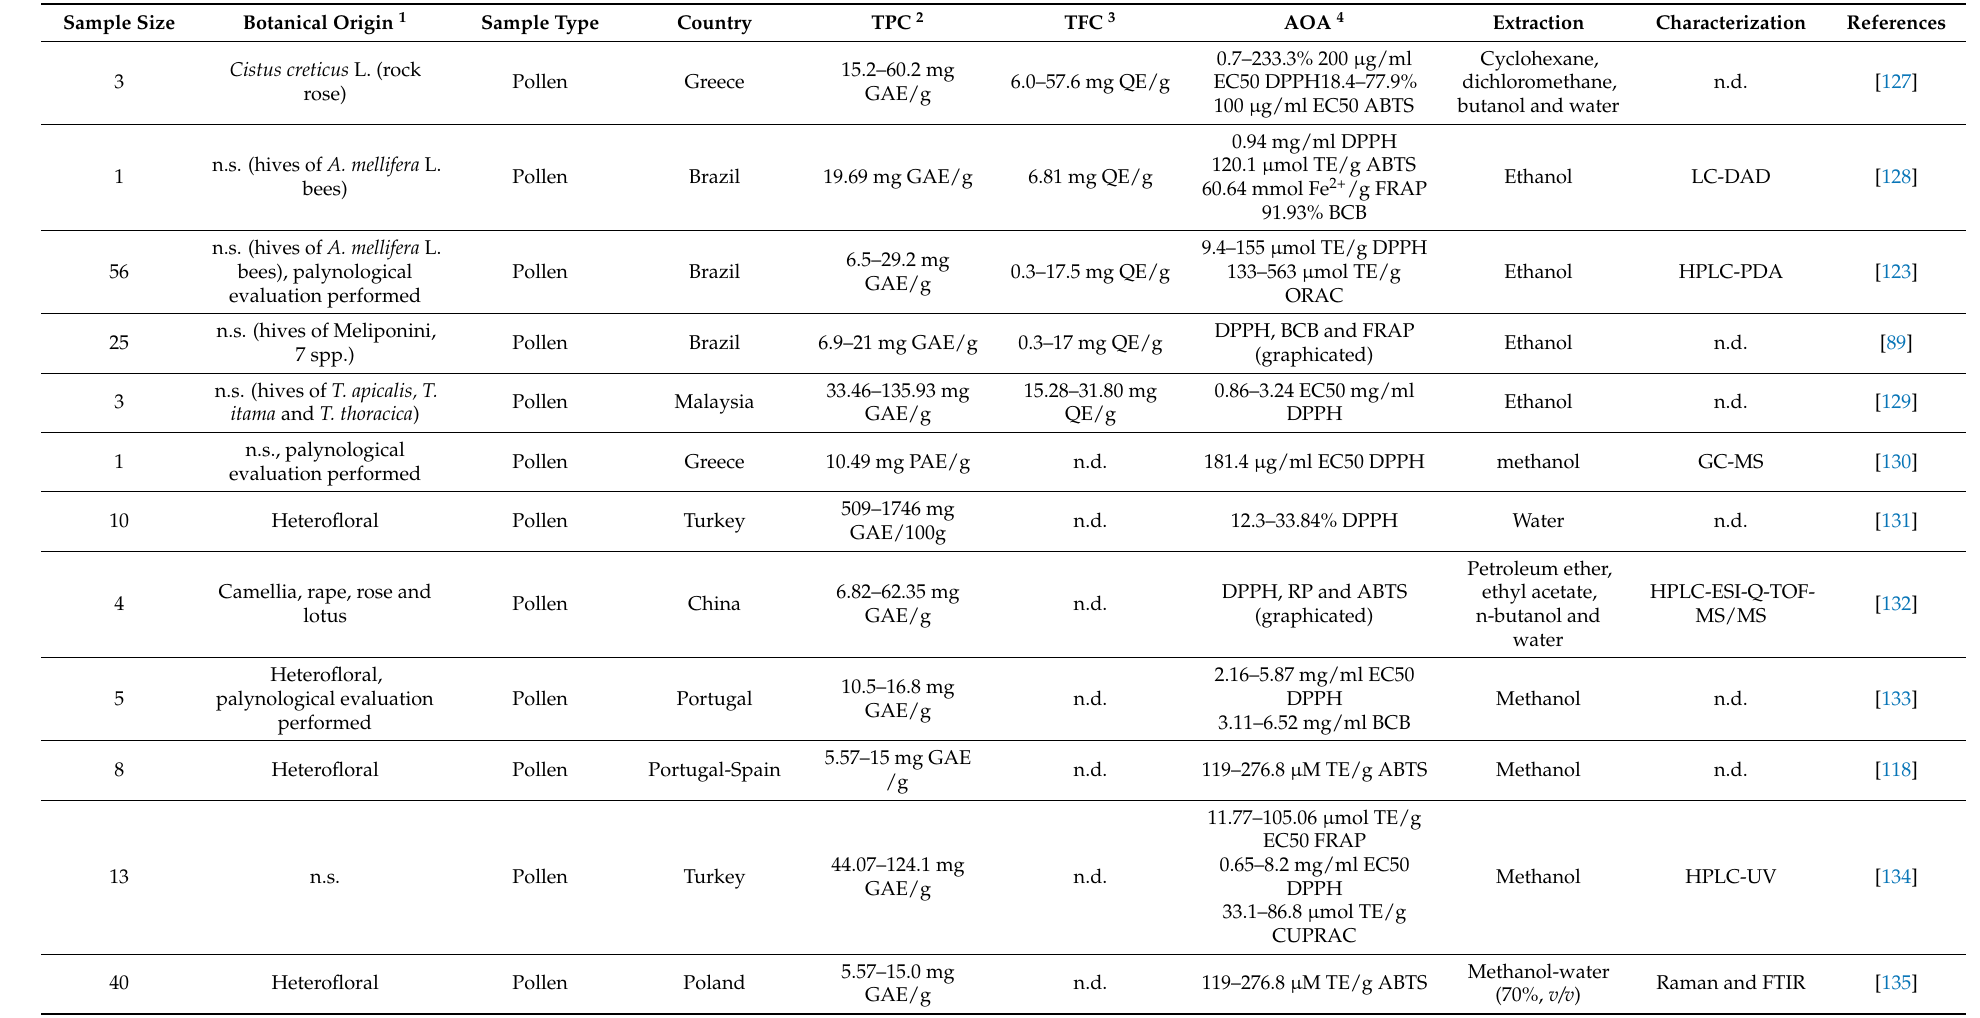
Table 3. Summary of the results from studies on antioxidant capacity in pollen and bee